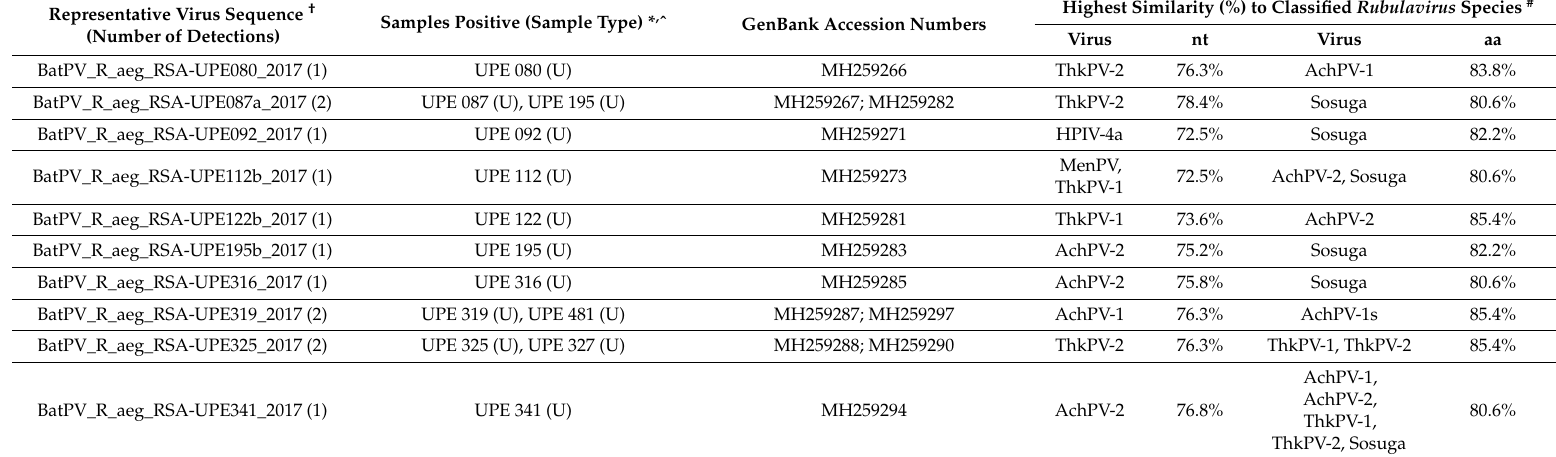
Representative Virus Sequence † (Number of